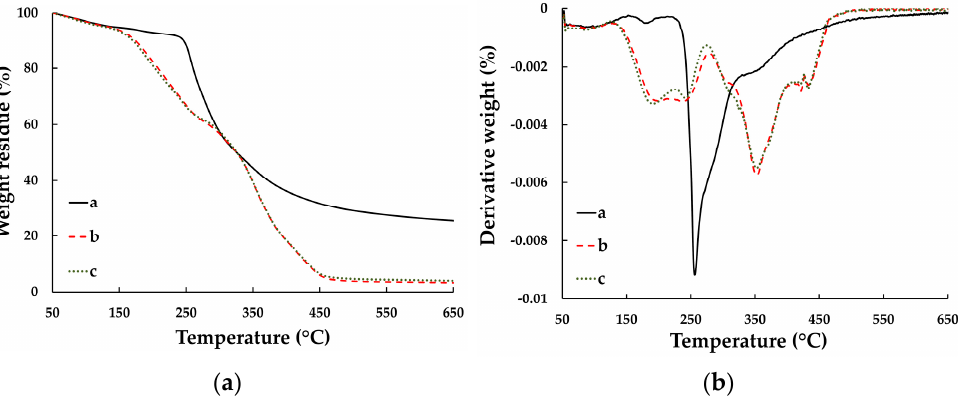
Figure 11. ( a ) TGA and ( b ) DTG thermograms of silver-nanoparticle-complexed G. applanatum , blank film, and topical film containing silver-nanoparticle-complexed G. applanatum .